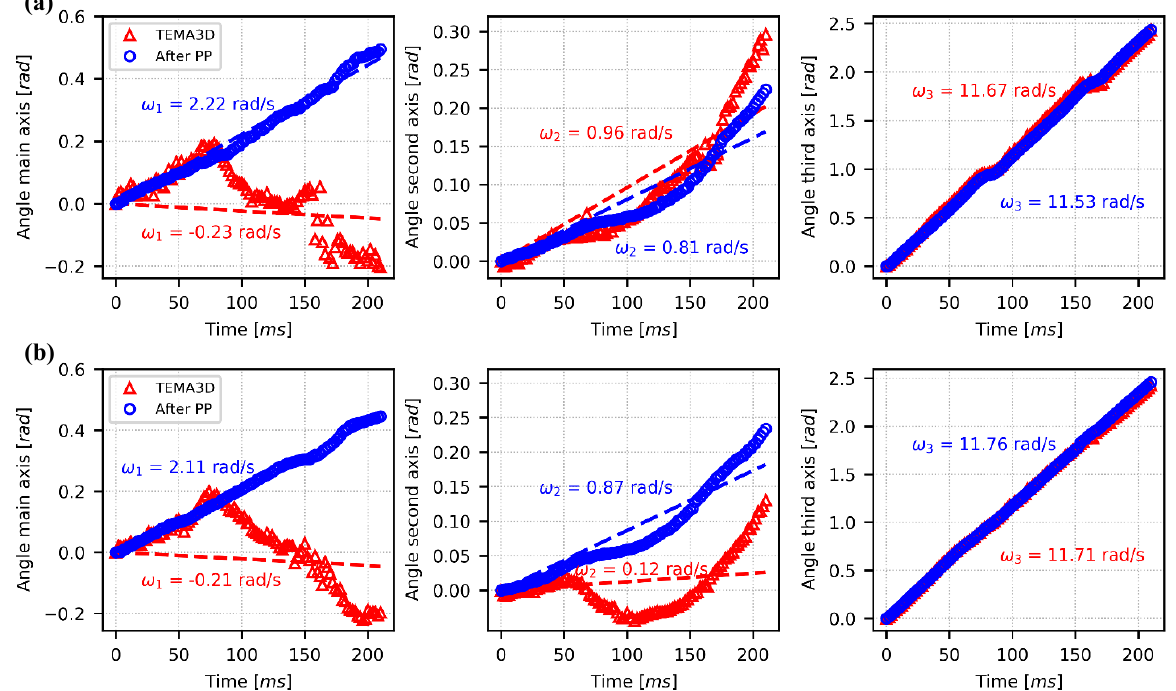
Figure 10. Cumulative rotation angles around the principal axes and corresponding estimated rotational velocities ( spinning brick calculated with (a) 4 views and (b) 6